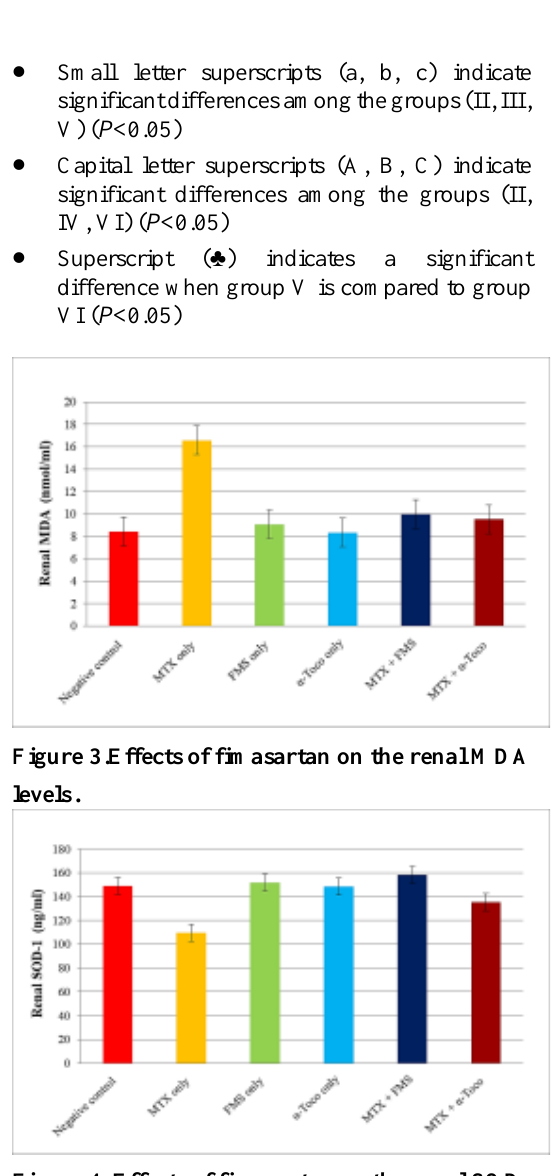
Figure 4. Effects of fimasartan on the renal SOD- 1 levels.